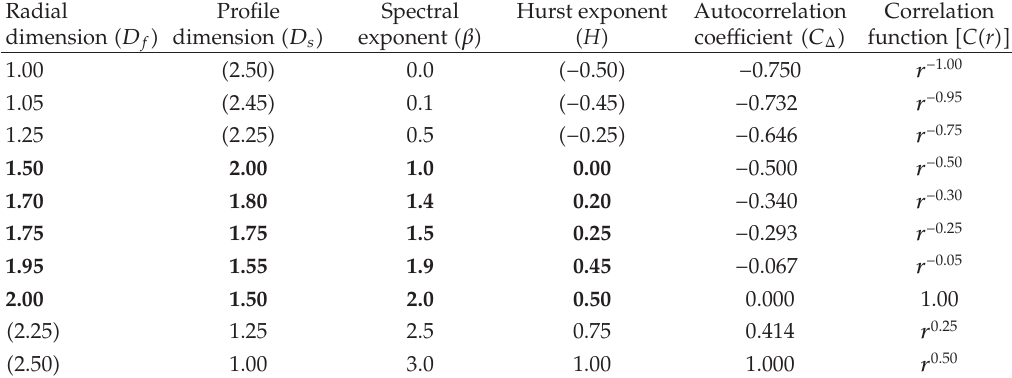
Table 1: The numerical relationships between di ff erent fractal dimensions, scaling exponents, and autocorrelation coe ffi